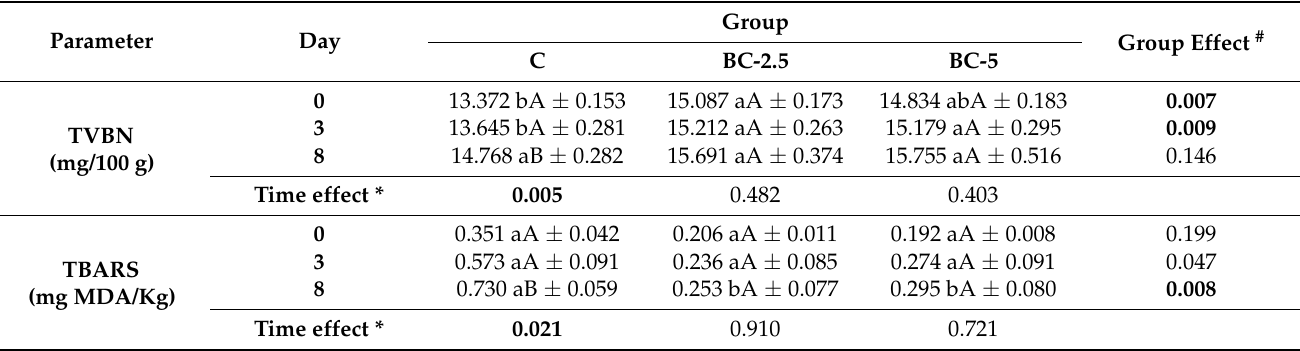
Figure 1. Effects of colostrum inclusion in the diet of rabbits on the content of saturated (SFAs) ( a ), monounsaturated (MUFAs) ( b ), polyunsaturated fatty acids (PUFAs) ( c ), percentage total peak area and ω - 6/ω -3 ratio ( d ) of the meat. C = control diet; BC-2.5 = diet supplemented with 2.5% bovine colostrum; BC-5 = diet supplemented with 5% bovine colostrum. p -Values are statistically significant at α = 0.05. a, b: Values followed by the same letter do not differ significantly.